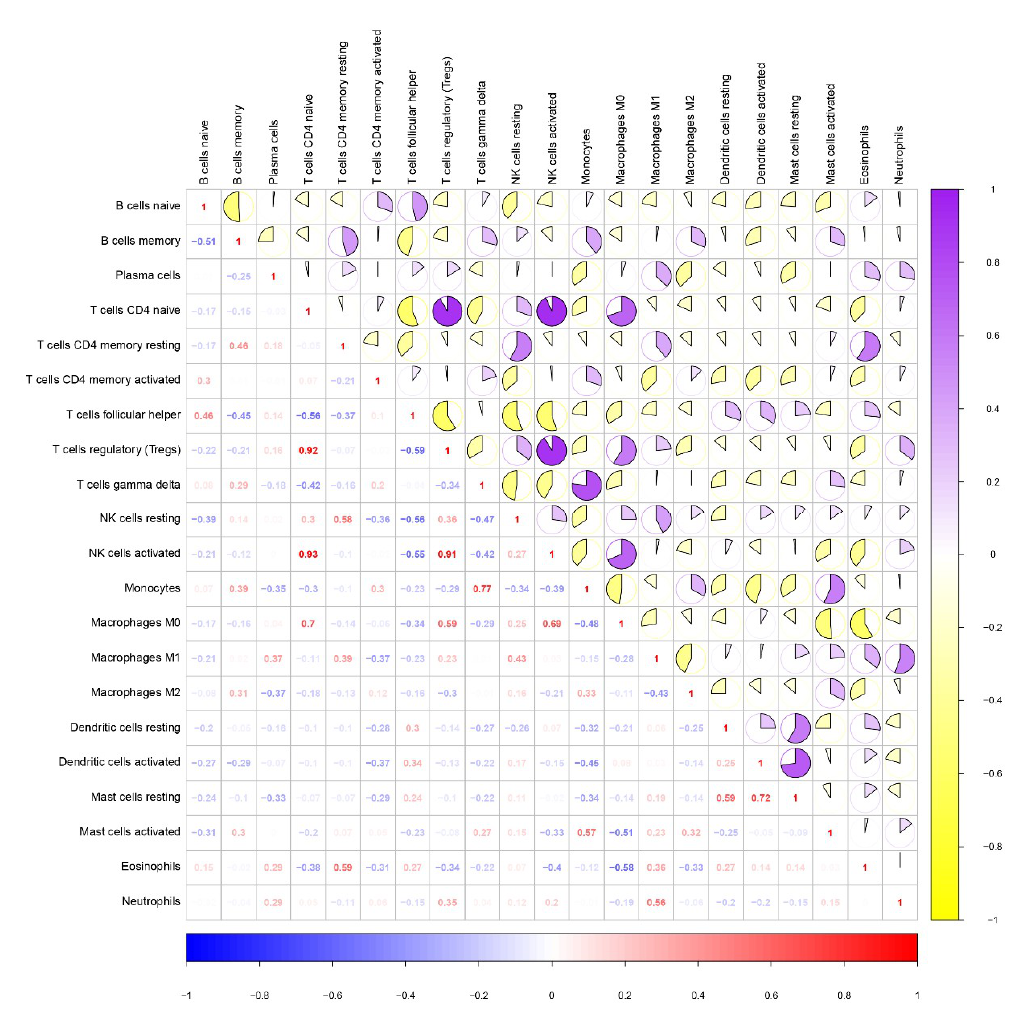
Figure 9. Correlation matrix of proportions of all immune cells. Some immune cells are negatively correlated (shown in yellow), while others are positively correlated (shown in purple). The darker the color, the higher the correlation ( p < 0.05).